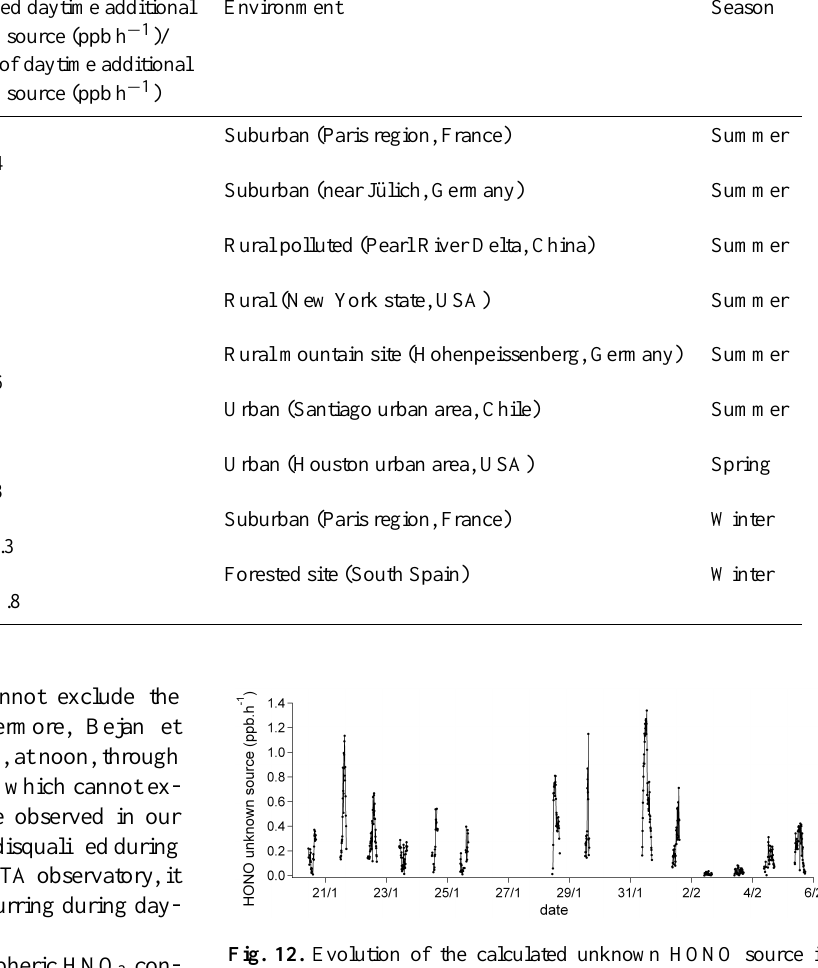
Fig. 12. Evolution of the calculated unknown HONO source in ppbh − 1 (Eq. 4) during the MEGAPOLI winter